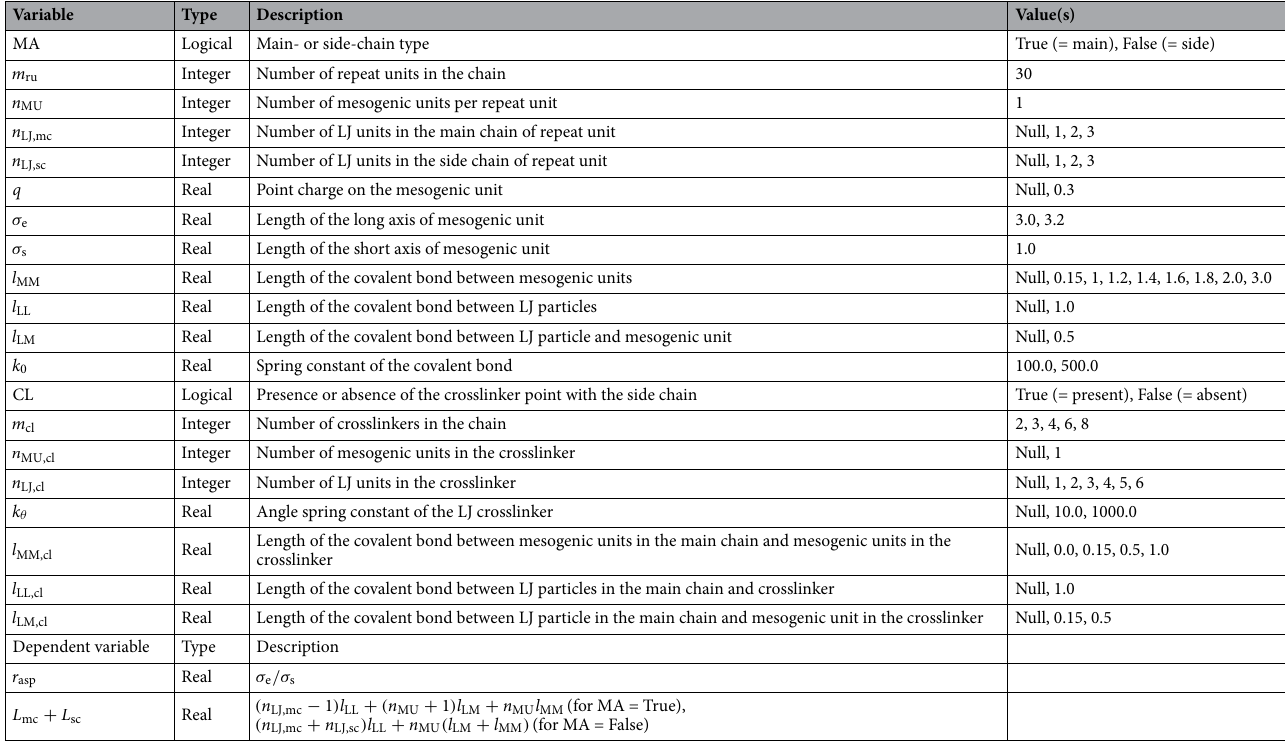
Table 1. Design variables for LCE molecules. Variables that depend on some of the design variables are also displayed. The value “null” indicates that the variable does not exist in the molecular architecture.